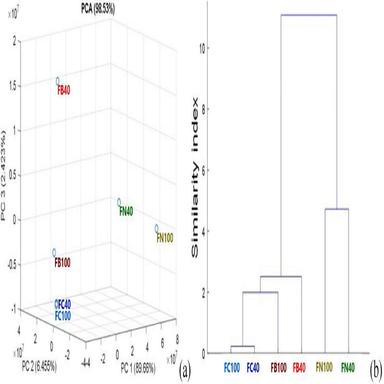
PCA plot (a) and the hierarchical clustering (b) of the fir bark, needles and cones according to the composition of ethanol/toluene extractive fractions.